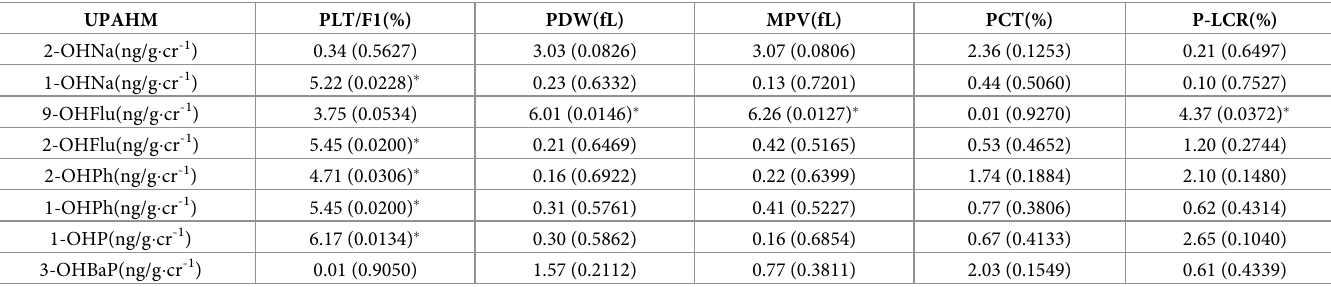
Table 2. The fixed effect among platelet indices and UPAHM based on